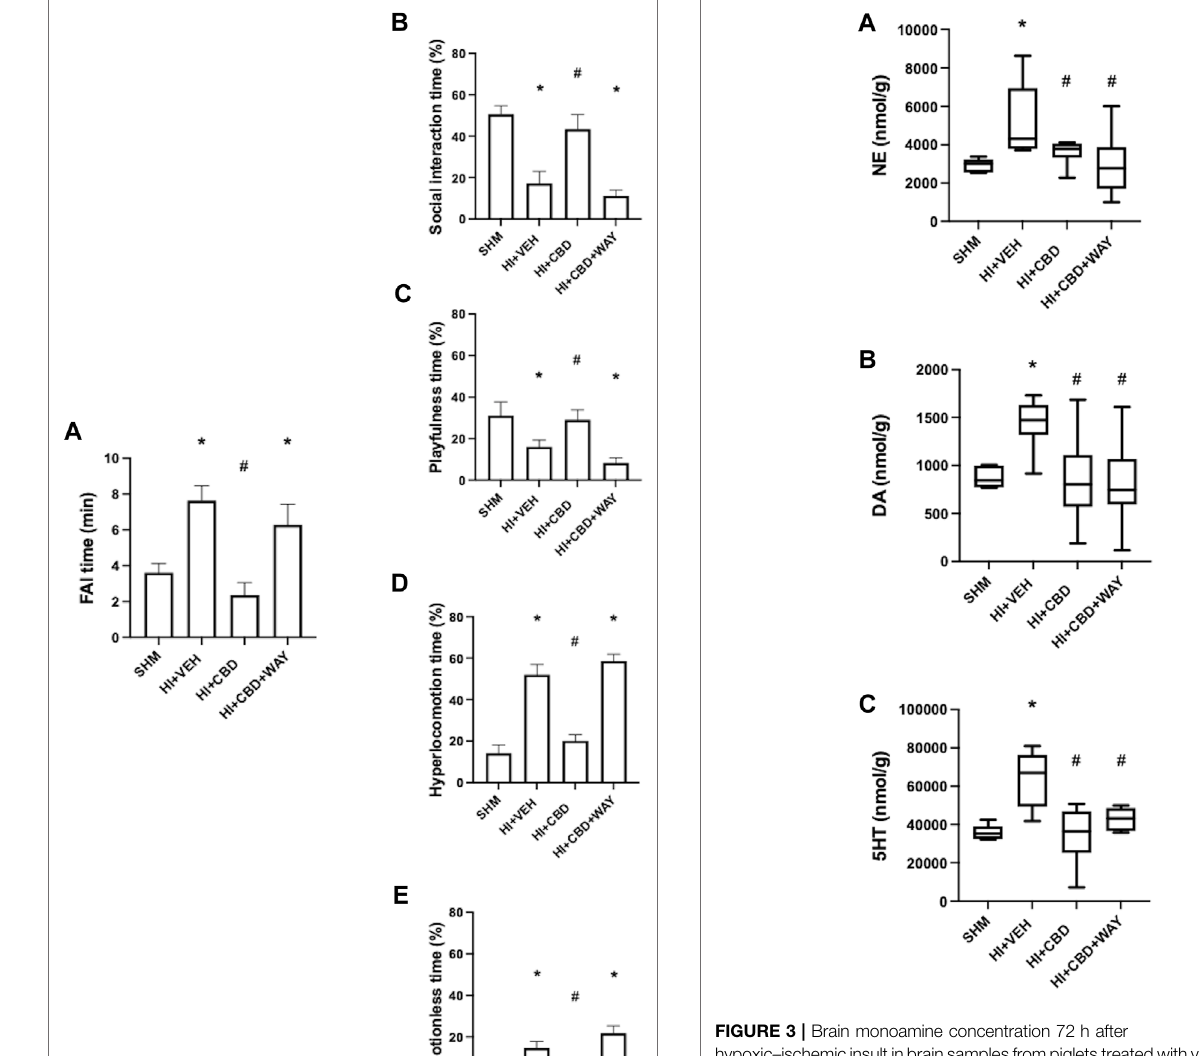
Frontiers in Pharmacology |